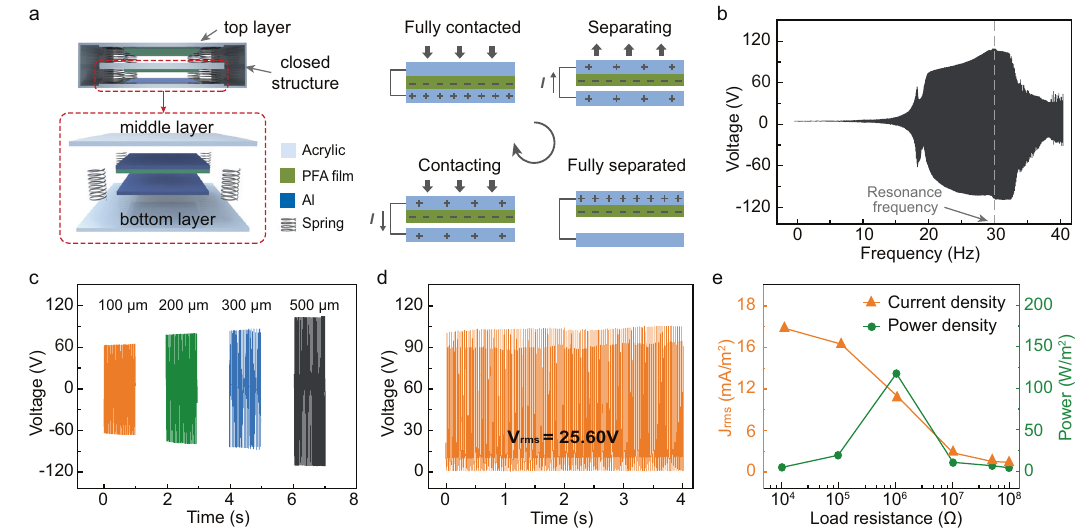
Fig. 2 Construction and output of the vibration-driven triboelectric nanogenerator (V-TENG). a Schematics showing the structure (left) and the working mechanism (right) of the V-TENG. b Output voltages of the bottom and middle layers of the V-TENG with a vibration frequency sweep from 1 to 40 Hz at a constant amplitude (500 μ m). The largest output occurs when the vibration frequency is the same as the resonance frequency of the V-TENG (30Hz). c Output voltages of the V-TENG at various amplitudes (from 100 to 500 μ m) and a constant vibration frequency (30Hz). d Output voltages of the V-TENG after recti fi cation at a constant amplitude (500 μ m) and vibration frequency (30Hz). e The root mean square current density ( J rms ) and power ( P ) of the V- TENG after recti fi cation with various load resistances (from 10 4 to 10 8 Ω ) when operated at a constant amplitude (500 μ m) and vibration frequency